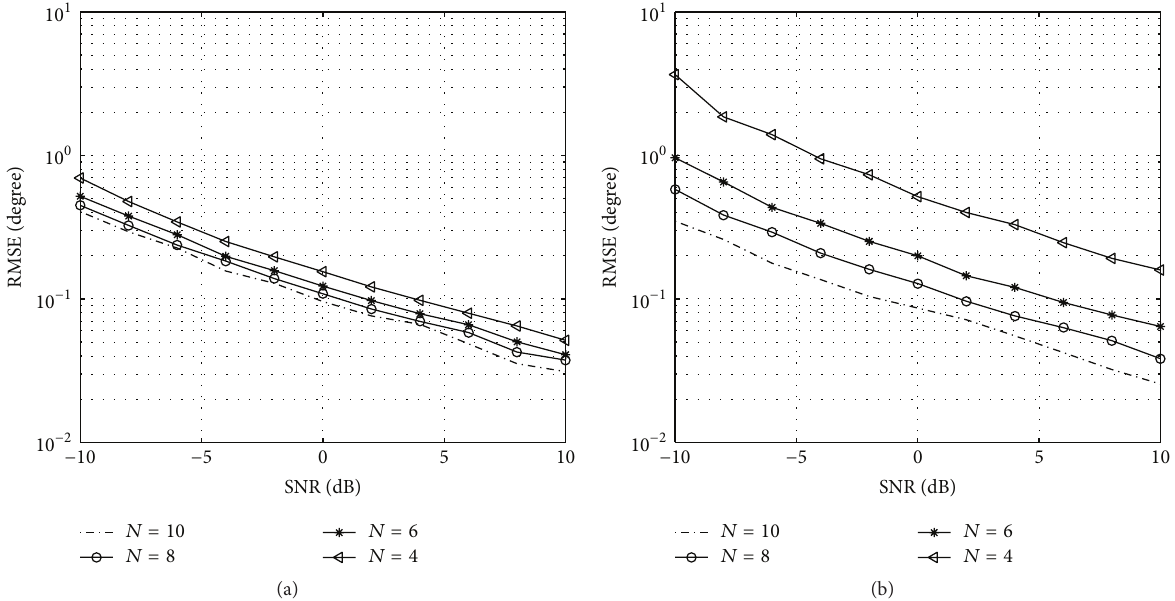
Figure 6: The performance for DOD and DOA estimation with different 𝑁 . (a) DOD and (b) DOA.